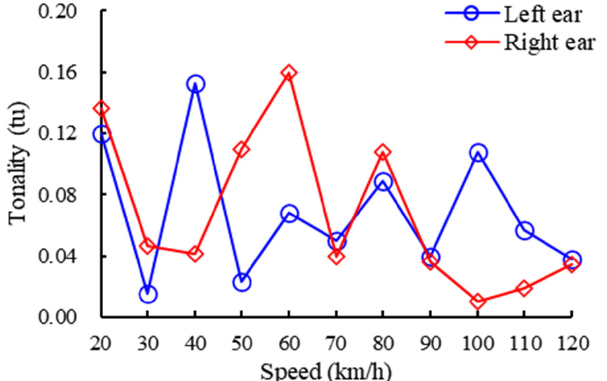
Figure 10. Interior noise tonality in the EV as a function of the vehicle’s speed.